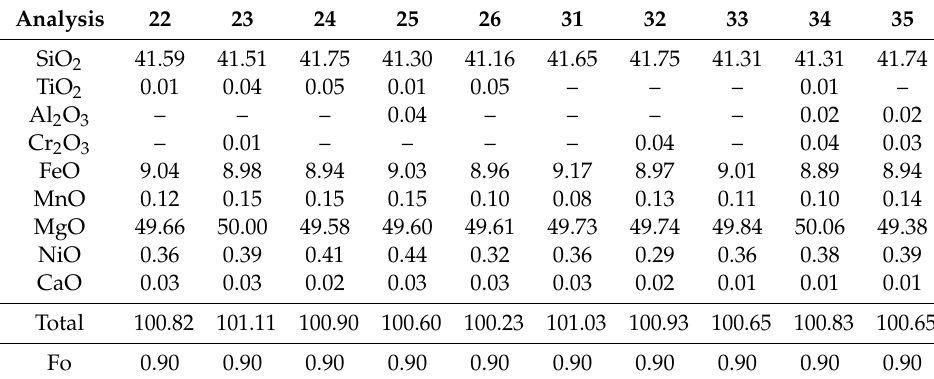
Table 7. Mineral chemistry of olivine grains from sample W5. Analyses No. 22–26 are from the olivine grains with Fe inclusions, whereas analyses No. 31–35 are from olivine grains without inclusions (-- = below detection limit).